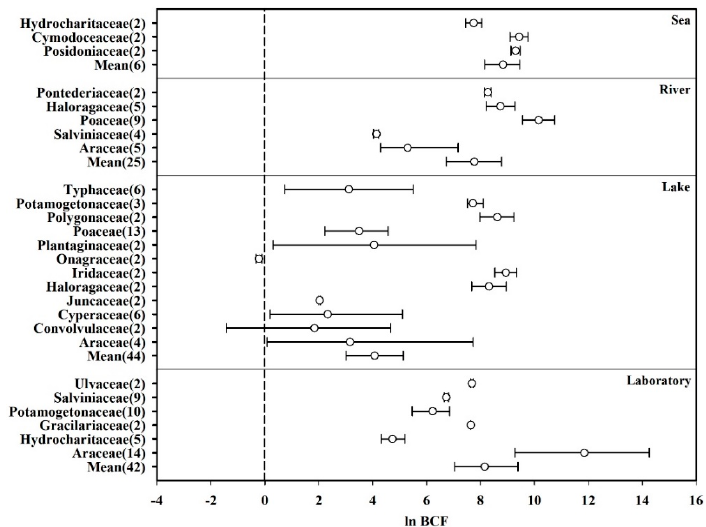
Figure 2. Biological concentration factors (BCFs) of plants based on their families, presented as the mean effect size and 95% CI. The numerals after the family names represent the number of observations. “Mean” indicates the overall effect considering all families.